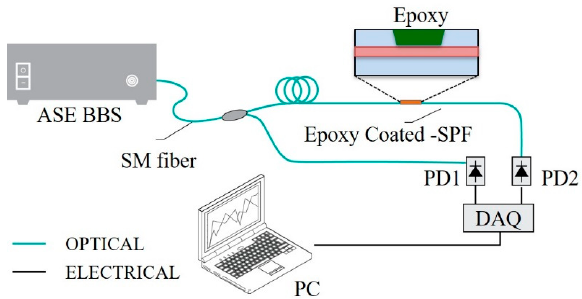
Figure 2. Experimental setup of the proposed fiber-optic sensor system. SM—single mode; SPF—side-polished fiber; PD—photo detector; DAQ—data acquisition; ASE BBS—amplified spontaneous emission broadband source.